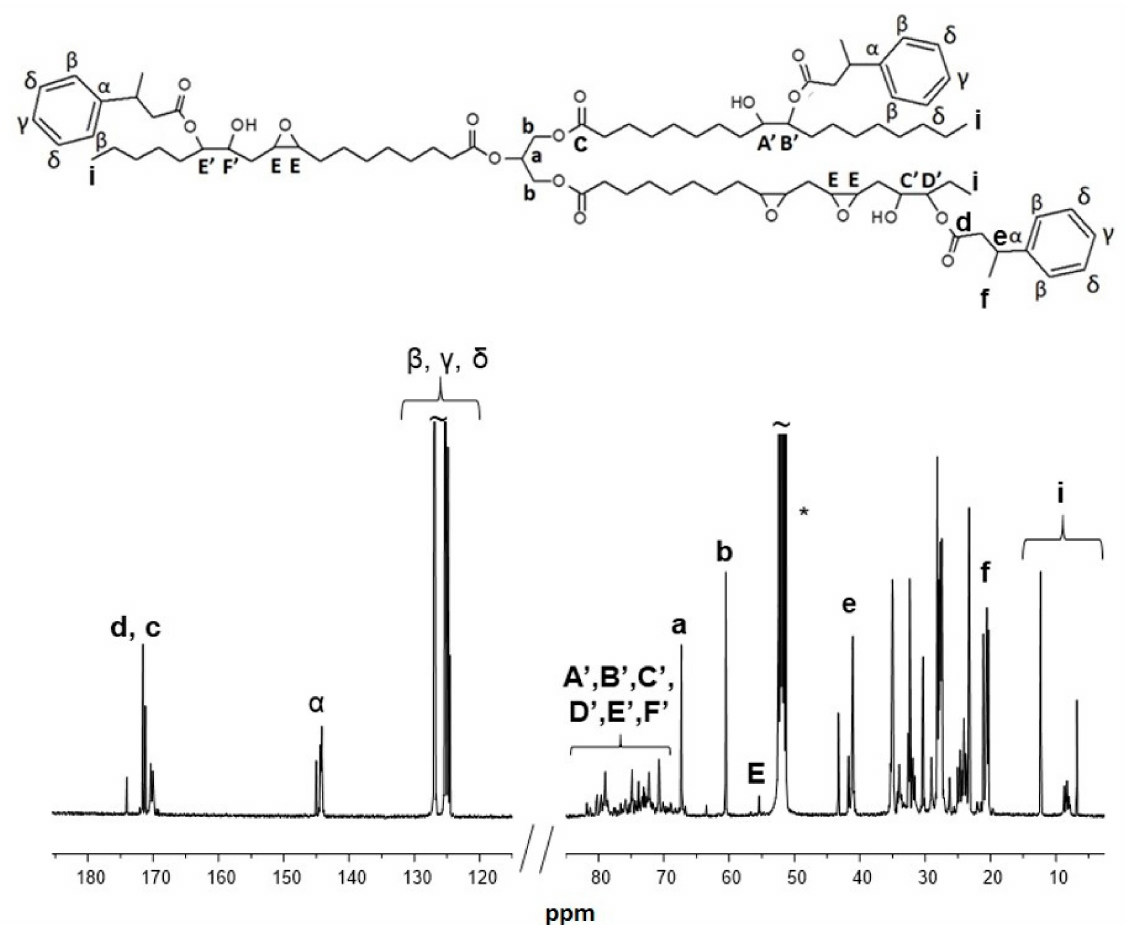
Figure 4. 13 C-NMR spectrum of bio-polyol from ELO (epoxidized linseed oil) and 3-phenyl butyric acid (run 11 in Table 1). * CD 2 Cl 2 was used as solvent.